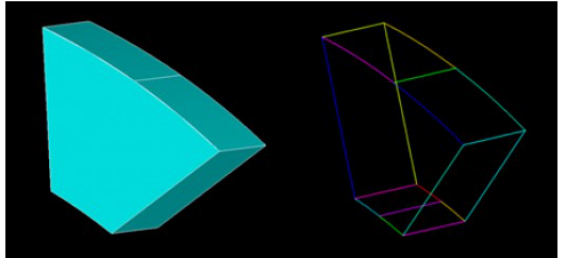
Figure 5. Through holes in implant